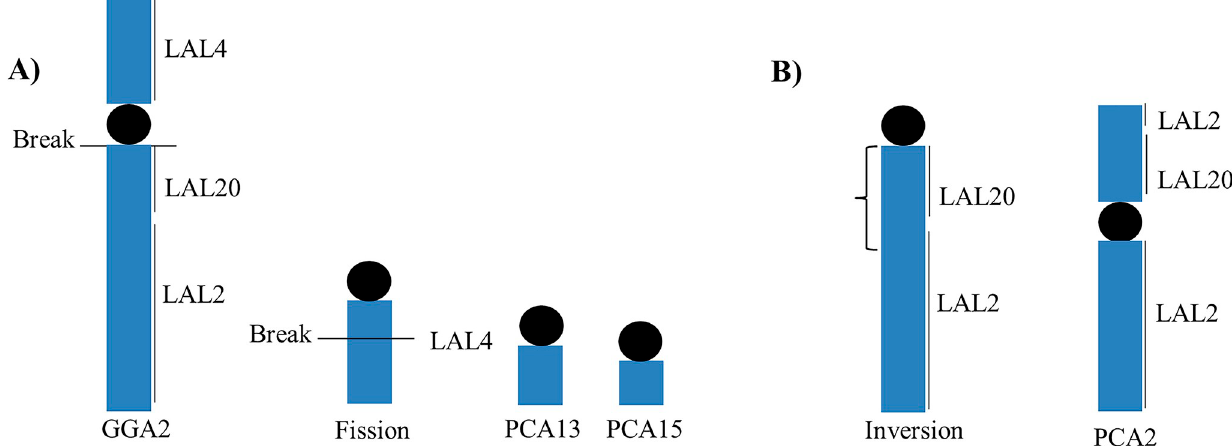
Fig 7. Schematic representation of the structural rearrangements found in PCA2, PCA13, PCA15 and GGU3. Two fissions in the ancestral synteny homologous to GGA2 led to two chromosome pairs, homologous to GGA2p (A) and one chromosome pair homologous to GGA2q. GGA2q underwent a pericentric inversion, forming PCA2